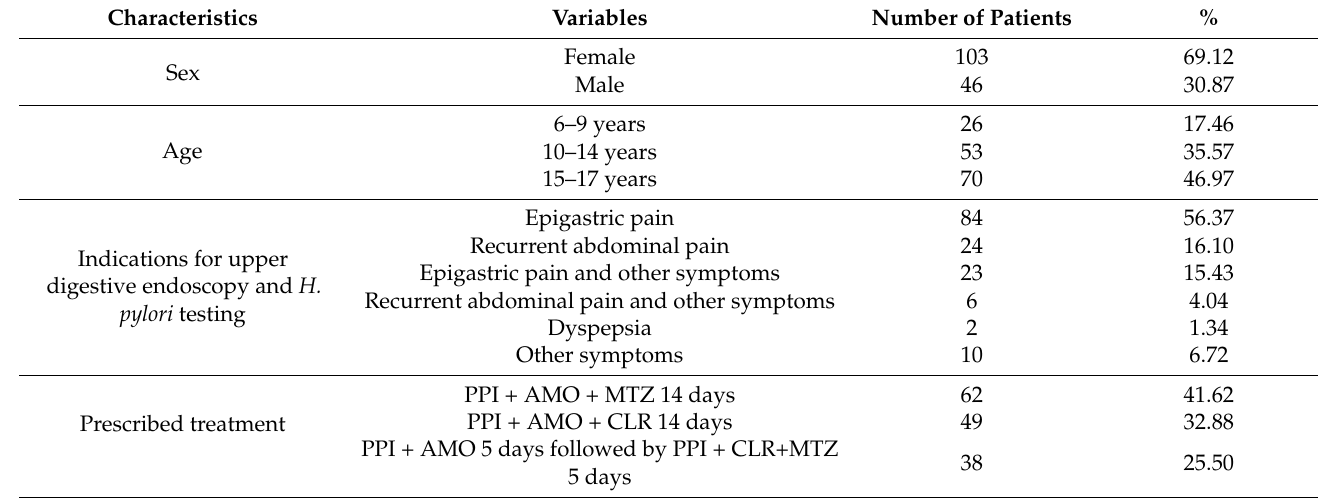
Table 1. The characteristics of the patients enrolled in the study.